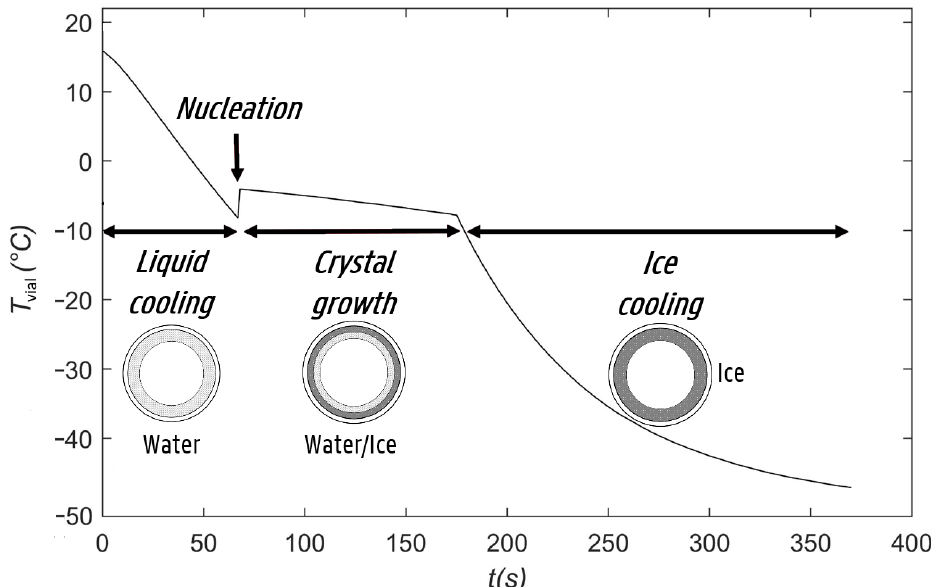
Figure 1. Diagram of vial temperature over time during the separate phases of cooling and freez- ing. The process starts with the cooling of the vial containing liquid product, until the nucleation temperature is reached. At this point, the temperature of the product within the vial increases up to the equilibrium temperature, and the ice crystallization phase starts. This phase ends when all water has crystallized into ice, whereafter the vial containing the now-solid product cools down until the final temperature. A cross-section of the vial during spin freezing is